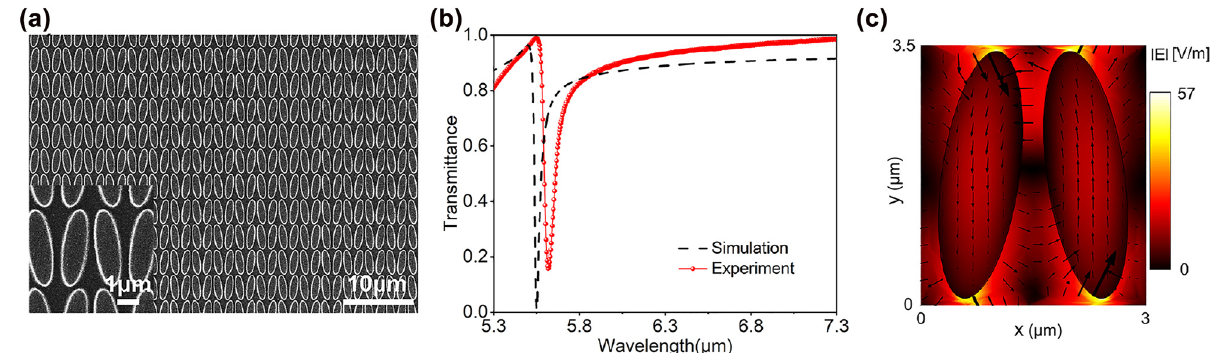
Figure 3: Characterization results of the metasurface. (a) An SEM image showing the top view of the fabricated elliptical disk zigzag metasurface array. (b) Transmission spectrum of the metasurface disk array with 𝜃 = 8 ◦ , where the black dashed line is extracted from numerical simulations while the red solid circles represent the experimentally measured results. (c) The amplitude as well as the vectorial distribution of the electric field across xy cross-sections of the elliptical